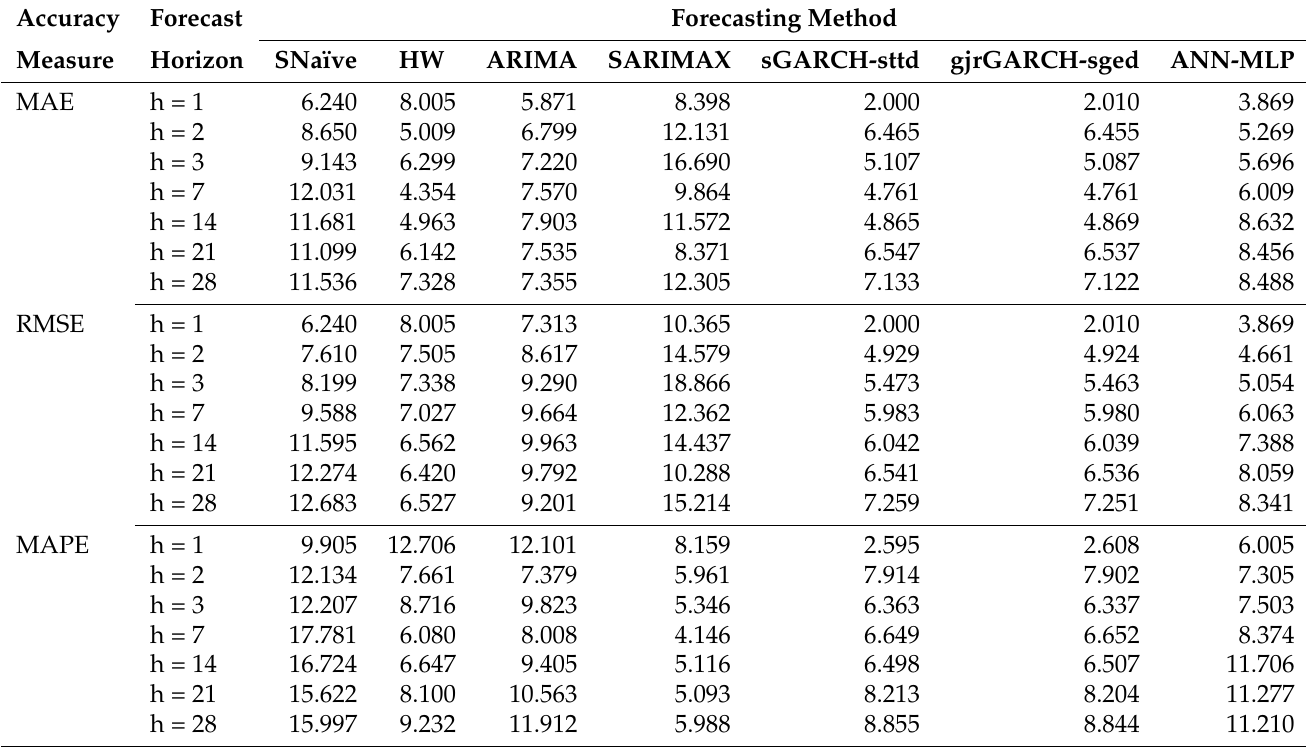
Table 2. Forecasting methods’